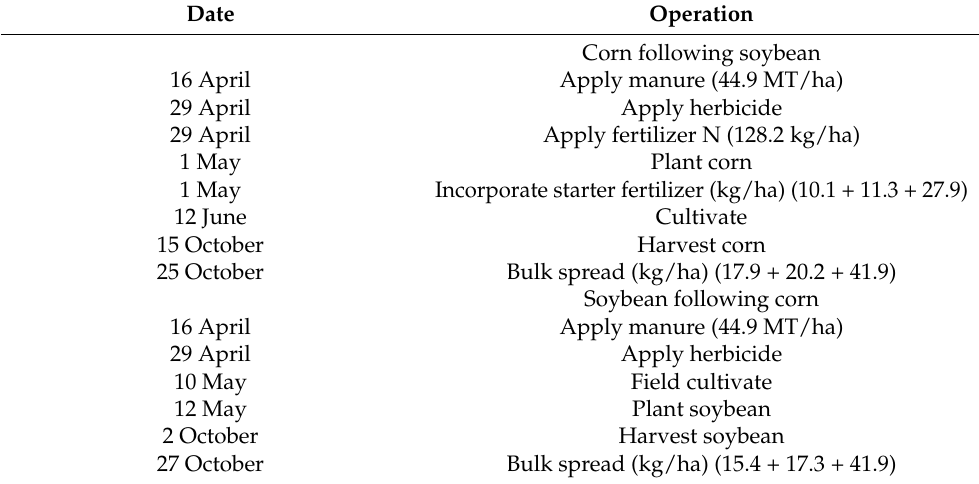
Table 2. Field operations simulated for no-till corn–soybean rotation for 1998–2000 production